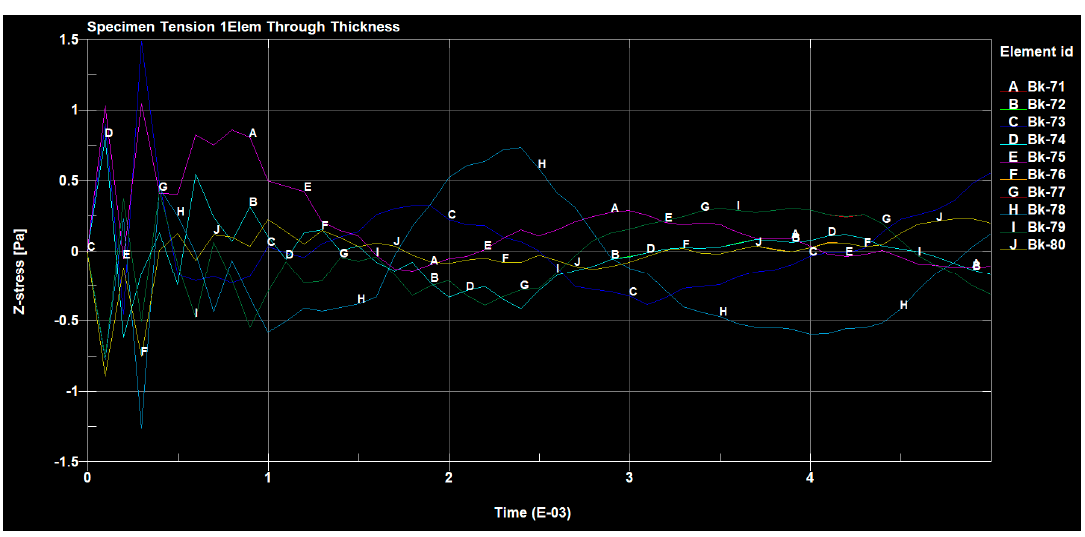
Figure 29. Sample deformation in the 𝑧 direction.